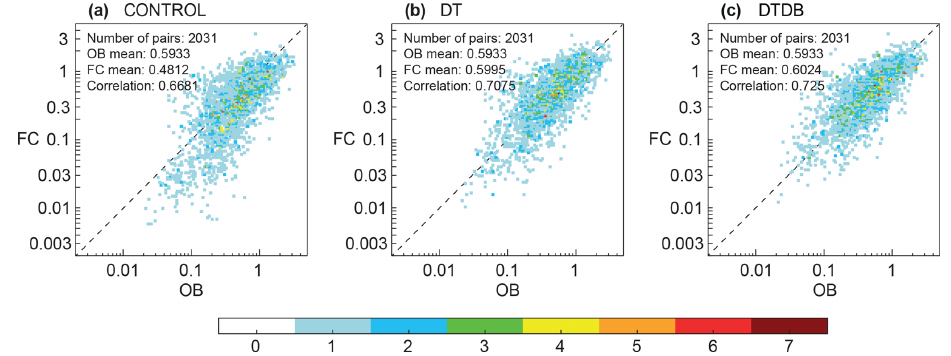
Figure 3. Two-dimensional histogram of modeled versus observed AOD at 440nm for all stations (33 in total) in central–northern China (30–45 ◦ N, 75–135 ◦ E). Panel (a) shows experiment CONTROL, panel (b) shows experiment DT and panel (c) shows experiment DTDB. FC stands for forecast (model simulation) and OB stands for observations.